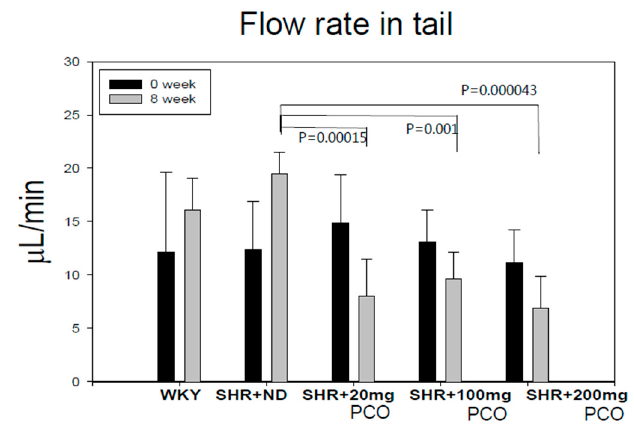
Figure 2. Changes in flow rate in tail during eight weeks of policosanol supplementation. ND, normal diet; PCO, policosanol.